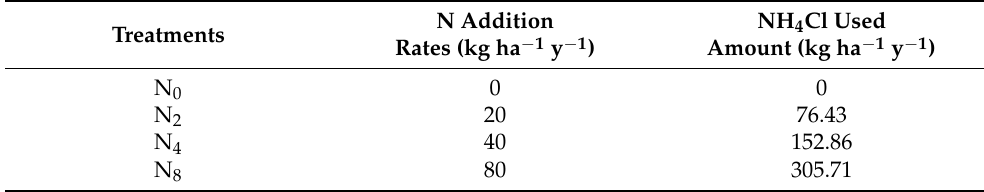
Table 1. The study